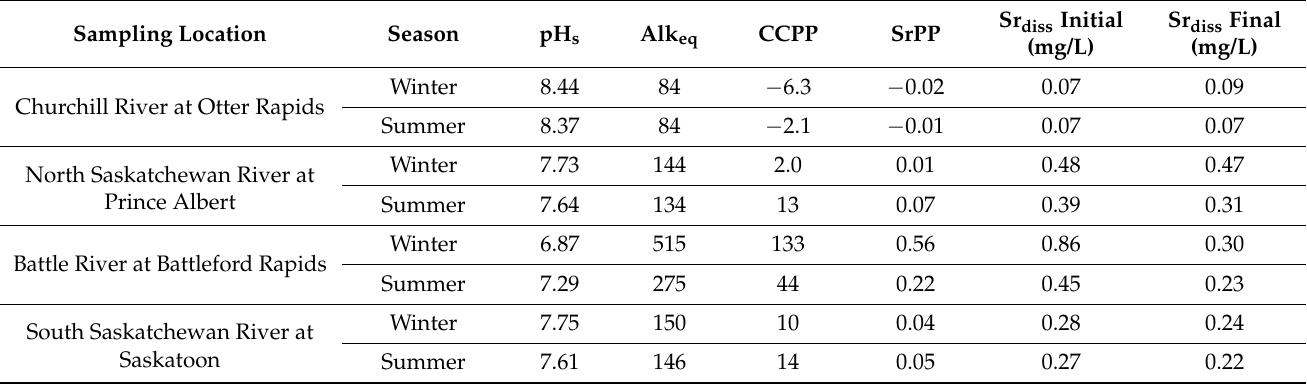
Table 3. Analysis of calcium and strontium precipitation potential of four major rivers in Saskatchewan,